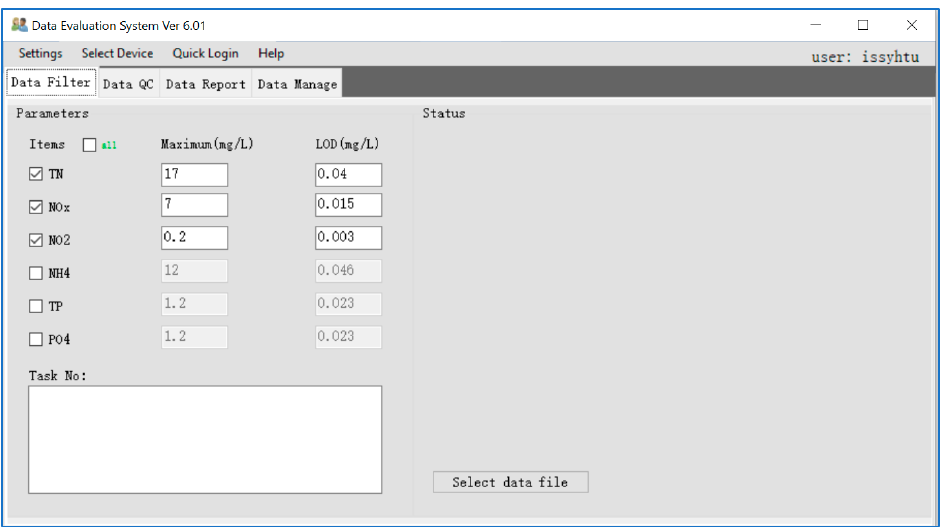
Figure 9. Flexible data evaluation system.